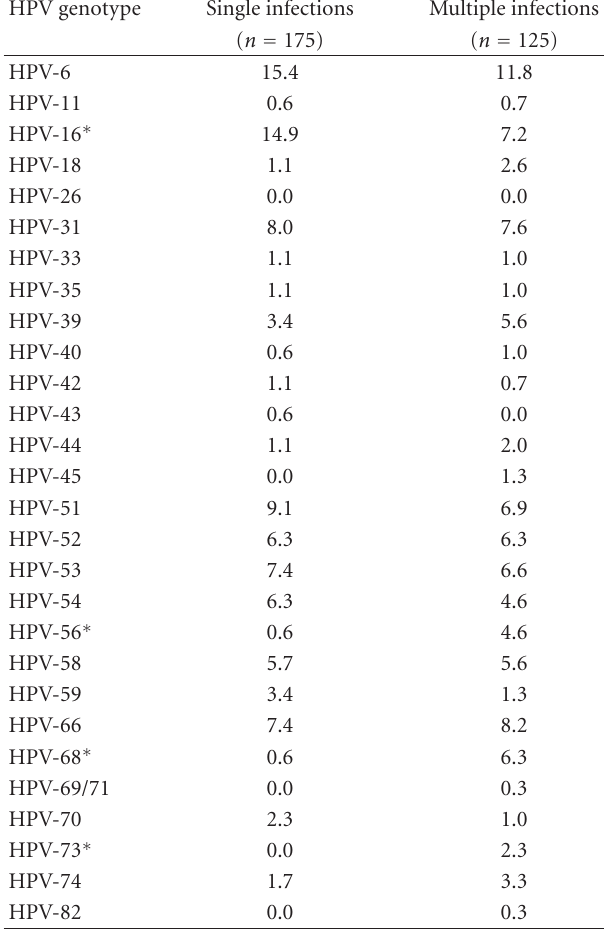
Table 1: HPV type distribution (%) in single and multiple